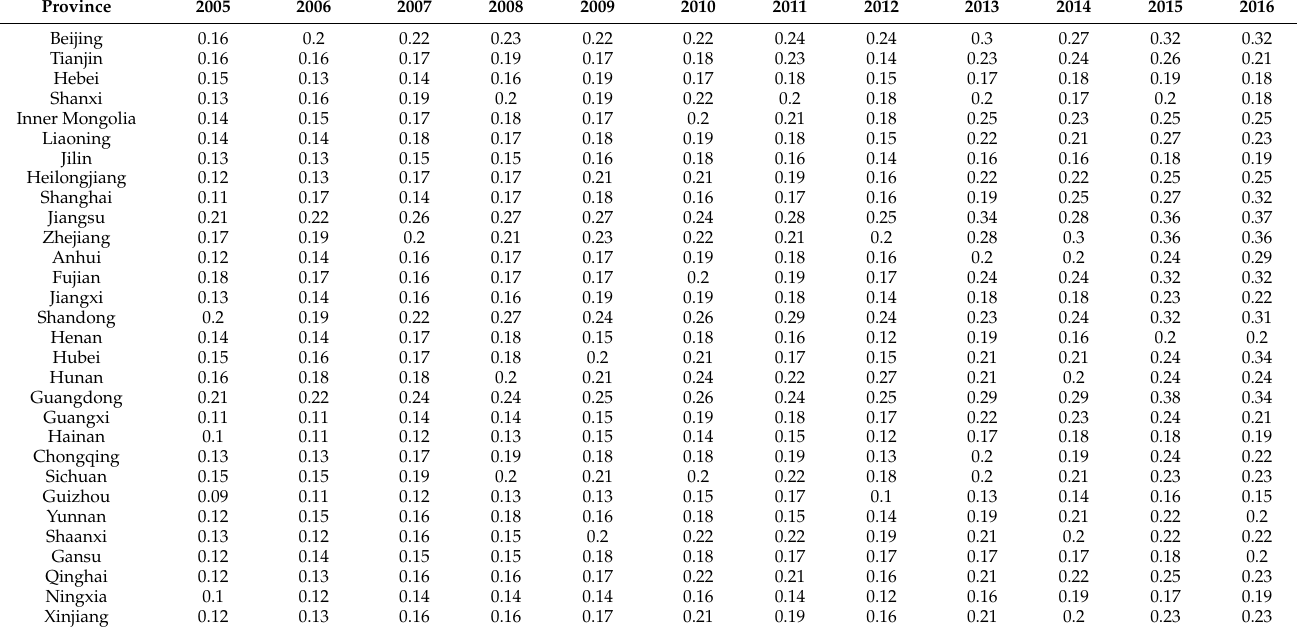
Table 6. Coordination degree between ecological environment and technological